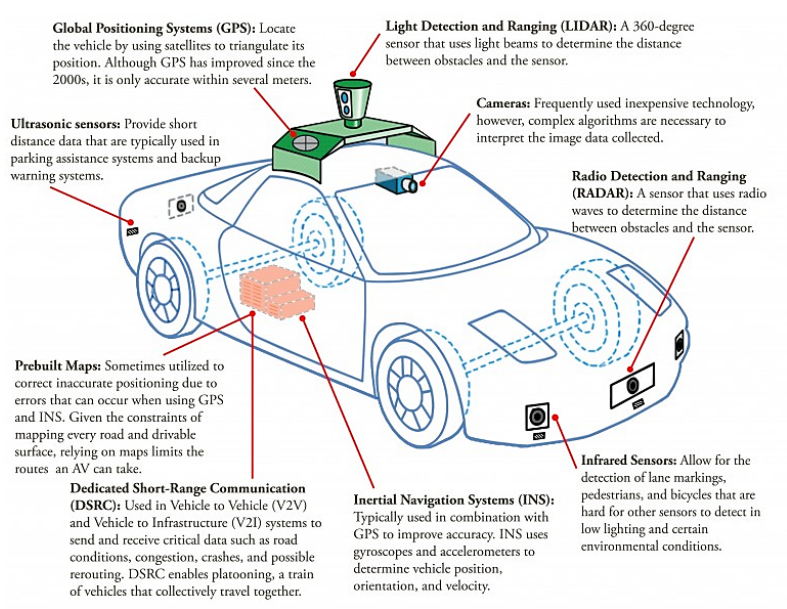
Figure 4. Autonomous vehicles sensor ecosystem (Image source: The